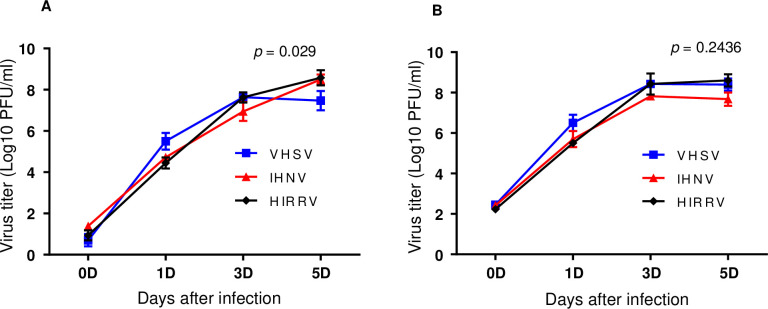
Growth kinetics of IHNV, VHSV, and HIRRV in HINAE cells.The cells were infected at a multiplicity of infection of (A) 0.1 or (B) 1 plaque-forming unit (PFU) per cell and samples of the supernatant medium were collected at the indicated time points. Viral titers were determined in duplicate by plaque assay on epithelioma papulosum cyprini (EPC) cells. Data are mean ± SD (n = 3). Two-way ANOVA. p values are indicated in the graphs.